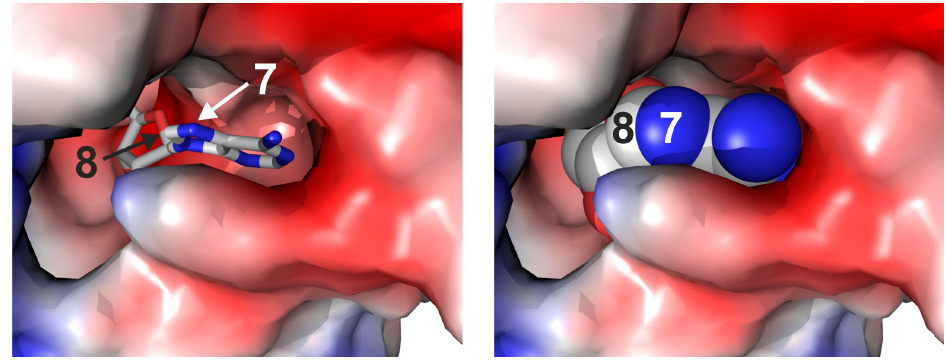
Figure 1. Cofactor binding pocket of the DNA MTase from Haemophilus haemolyticus (M.HhaI) (Protein Data Bank Entry Number 1MHT) shown as an electrostatic surface potential structure (red denotes negative potential, blue positive potential and white neutral). The bound demethylated cofactor product S -adenosyl- L -homocysteine (AdoHcy) is presented as a stick model ( left ) and as a space-filling model ( right ). The 7-position of the adenine ring is pointing towards the solvent, while the 8-position is partially blocked by the protein.